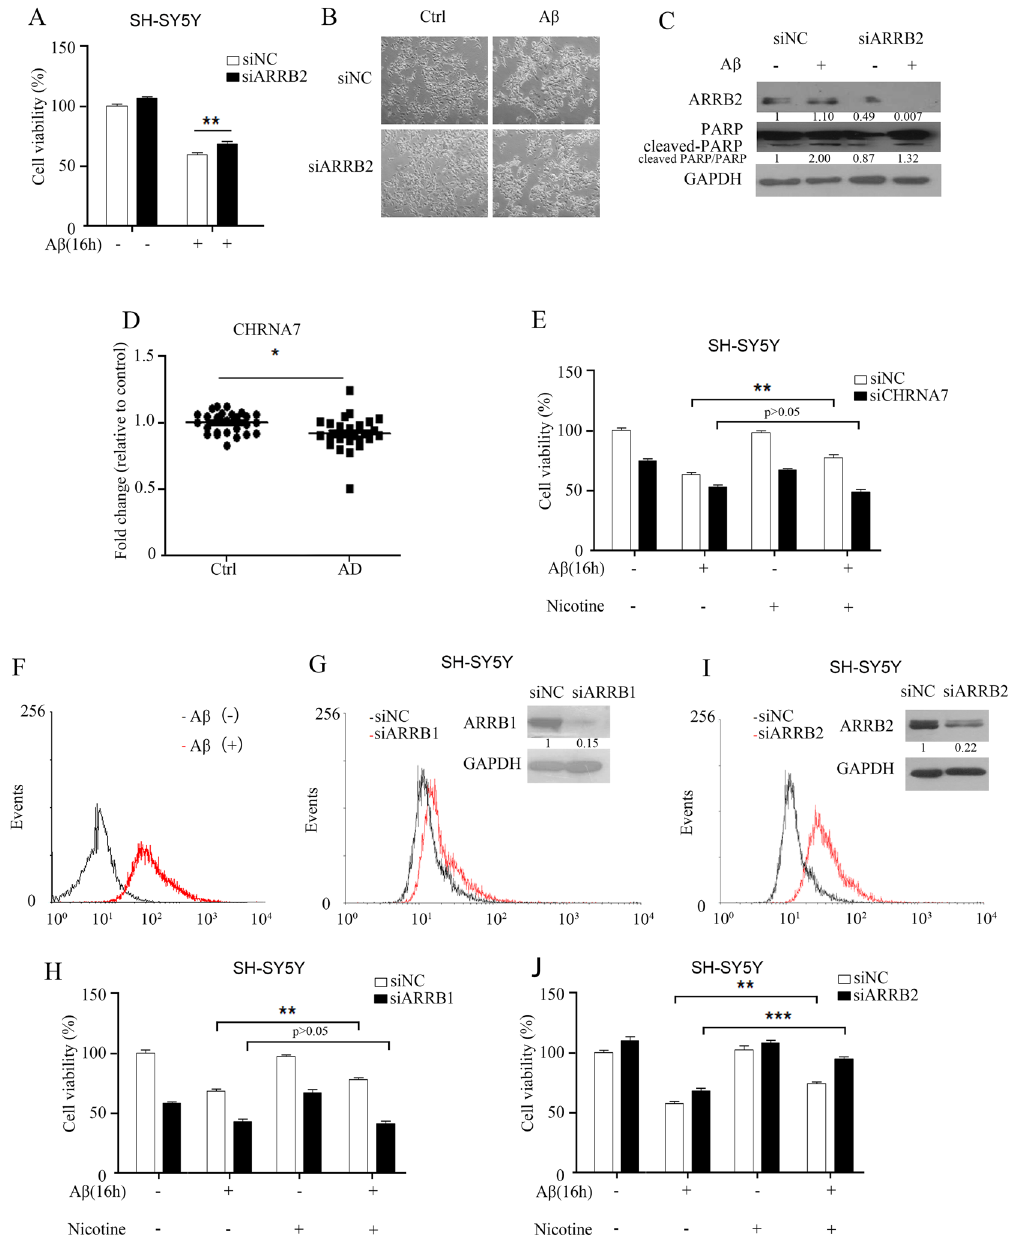
Figure 5. Knockdown of ARRB2 partially protects cells from A β 25–35 -induced apoptosis by facilitating α 7nAChR expression at the plasma membrane. ( A ) After the depletion of ARRB2, A β 25-35 -induced cytotoxicity was evaluated with the MTT assay. ** P < 0.01 compared with negative-control siRNA- and A β 25-35 -treated cells. ( B ) SH-SY5Y cells treated with A β 25-35 after depletion of ARRB2; changes in cell morphology were observed with a microscope. ( C ) SH-SY5Y cells treated with A β 25-35 after knockdown; the ARRB2 and apoptosis marker (PARP) was detected by western blot. ( D ) The mRNA level of chrna7 was detected from peripheral blood of AD patients by RT-PCR. * P < 0.05 compared to chrna7 mRNA of healthy controls. ( E ) After knockdown of chrna7 , cells were treated with or without nicotine before A β 25-35 treatment. ** P < 0.01 compared to cells with negative-control siRNA and A β 25-35 treatment and without nicotine pretreatment. ( F ) After A β 25-35 treatment, the expression of α 7nAChR in the cell membrane was detected by flow cytometry. ( G ) After arrb1 knockdown, the expression of α 7nAChR in the cell membrane was detected by flow cytometry. ARRB1 was detected by western blot. ( H ) After silencing of arrb1 , cells pretreated with nicotine before exposure to A β 25-35 were subjected to cell viability testing with the MTT assay. ** P < 0.01 compared to cells with negative-control siRNA and A β 25-35 treatment and without nicotine pretreatment. ( I ) After arrb 2 knockdown, the expression of α 7nAChR in the cell membrane was detected by flow cytometry. ARRB2 was detected by western blot. ( J ) After silencing of arrb2 , cells pretreated with or without nicotine before exposure to A β 25-35 were subjected to cell viability testing with the MTT assay. *** P < 0.001, ** P < 0.01 compared to cells with negative-control siRNA and A β 25-35 treatment and without nicotine pretreatment. The raw data of figure C/G/I is the figure 5C/5G/5I in supplemental